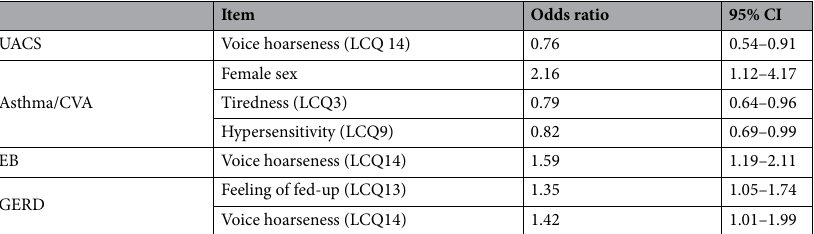
Table 3. Multivariable analysis and relative impact of each item on cause of chronic cough. UACS upper airway cough syndrome, CVA cough variant asthma, EB eosinophilic bronchitis, GERD gastro-esophageal reflux disease, LCQ Leicester cough questionnaire, CI confidence interval.